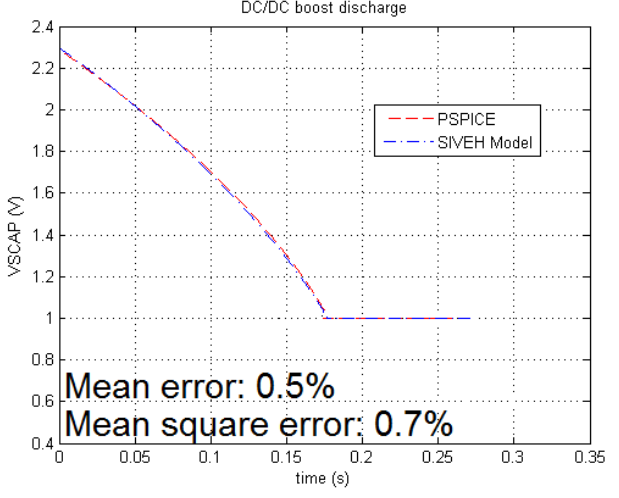
Figure 3. SPICE vs . MatLab step-up DC-DC converter.